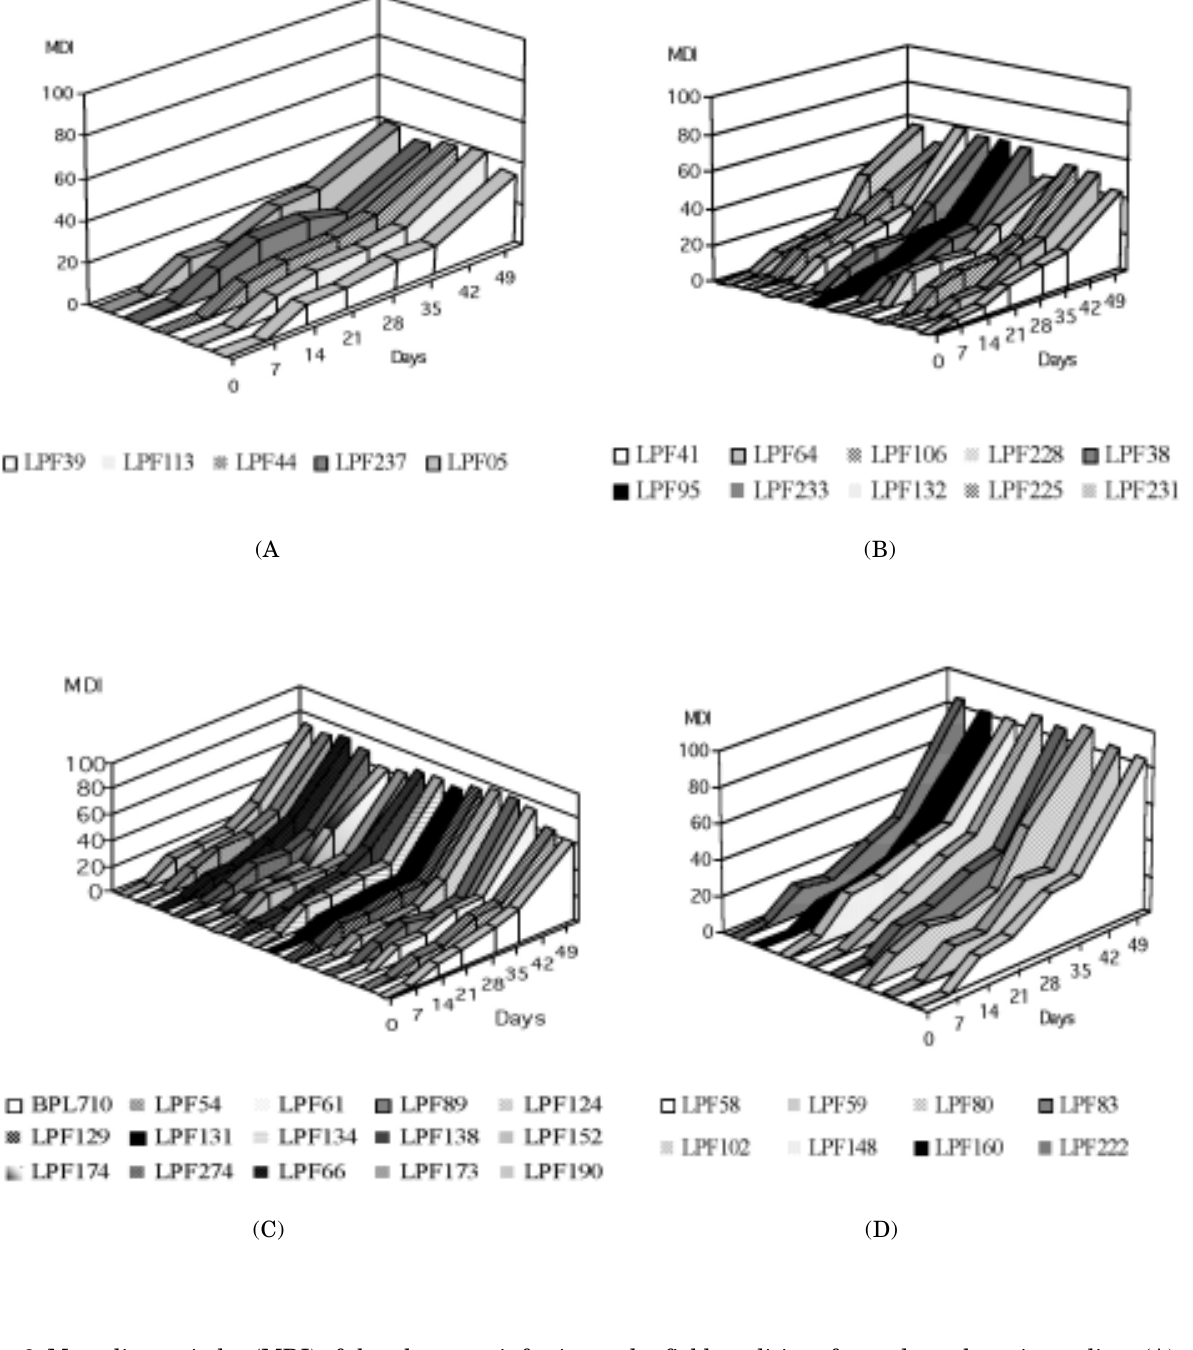
Fig. 2. Mass disease index (MDI) of chocolate spot infection under field conditions for moderately resistant lines (A); moderately susceptible lines with low area under disease progress curve (AUDPC) values (B); susceptible lines with low AUDPC values (C); highly susceptible lines